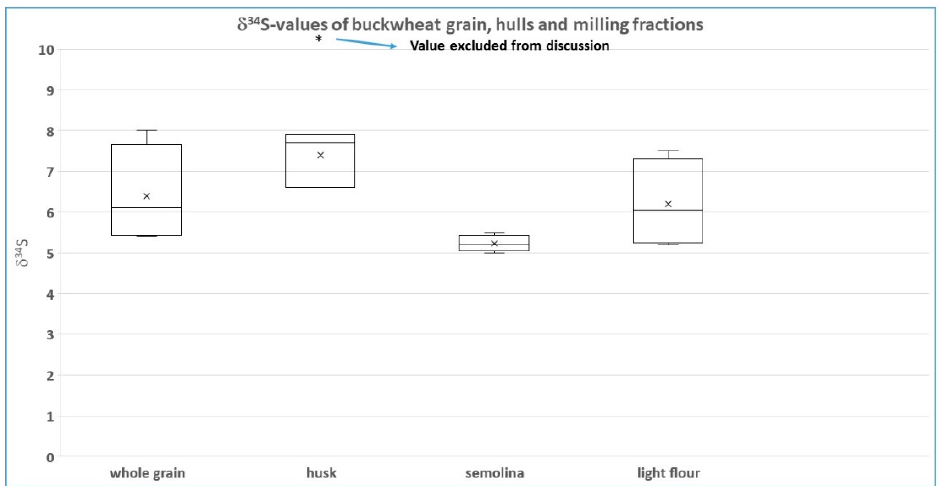
Figure 1. δ 34 S-values of the organic buckwheat (sub)samples collected over 2 years by Sinkovic et al. [1]. Asterisk marks the one (hulls)-sample discarded by the authors. Note the low variability of the semolina fraction.